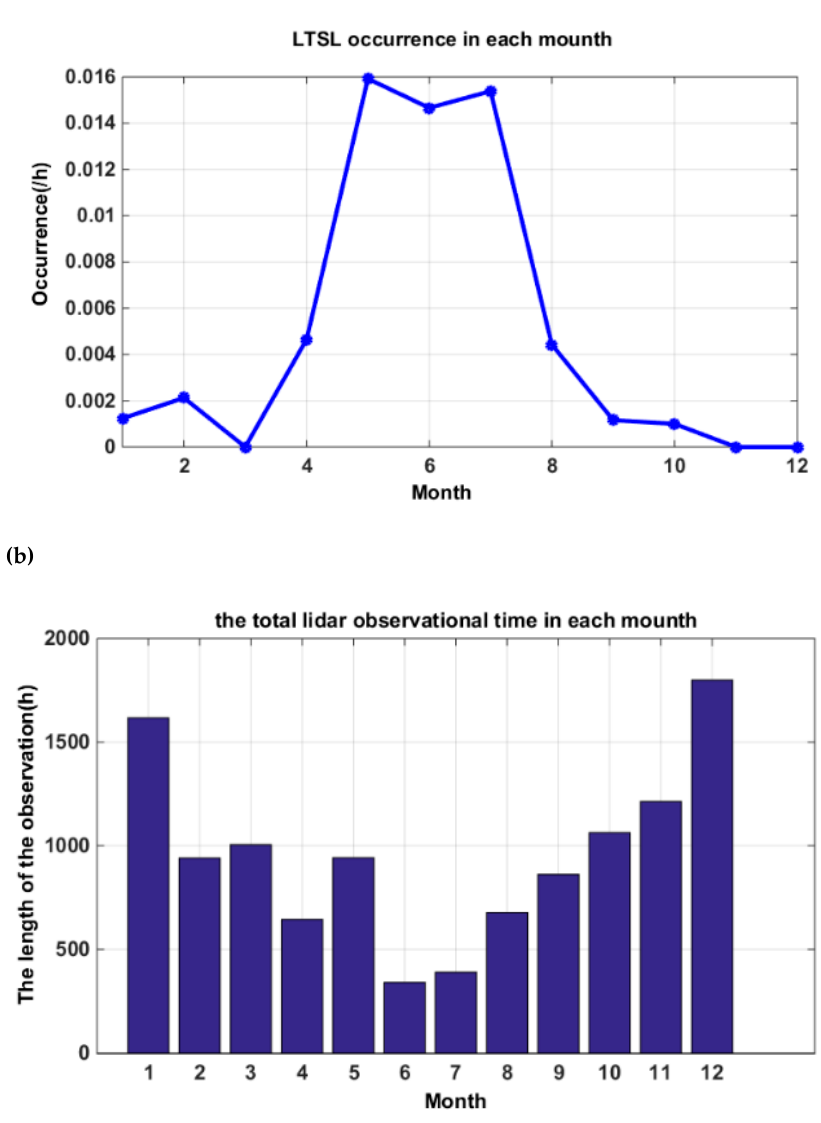
Figure 3. ( a ) The seasonal variations of the LTSL occurrence rates and ( b ) the observation time of lidar in each month.